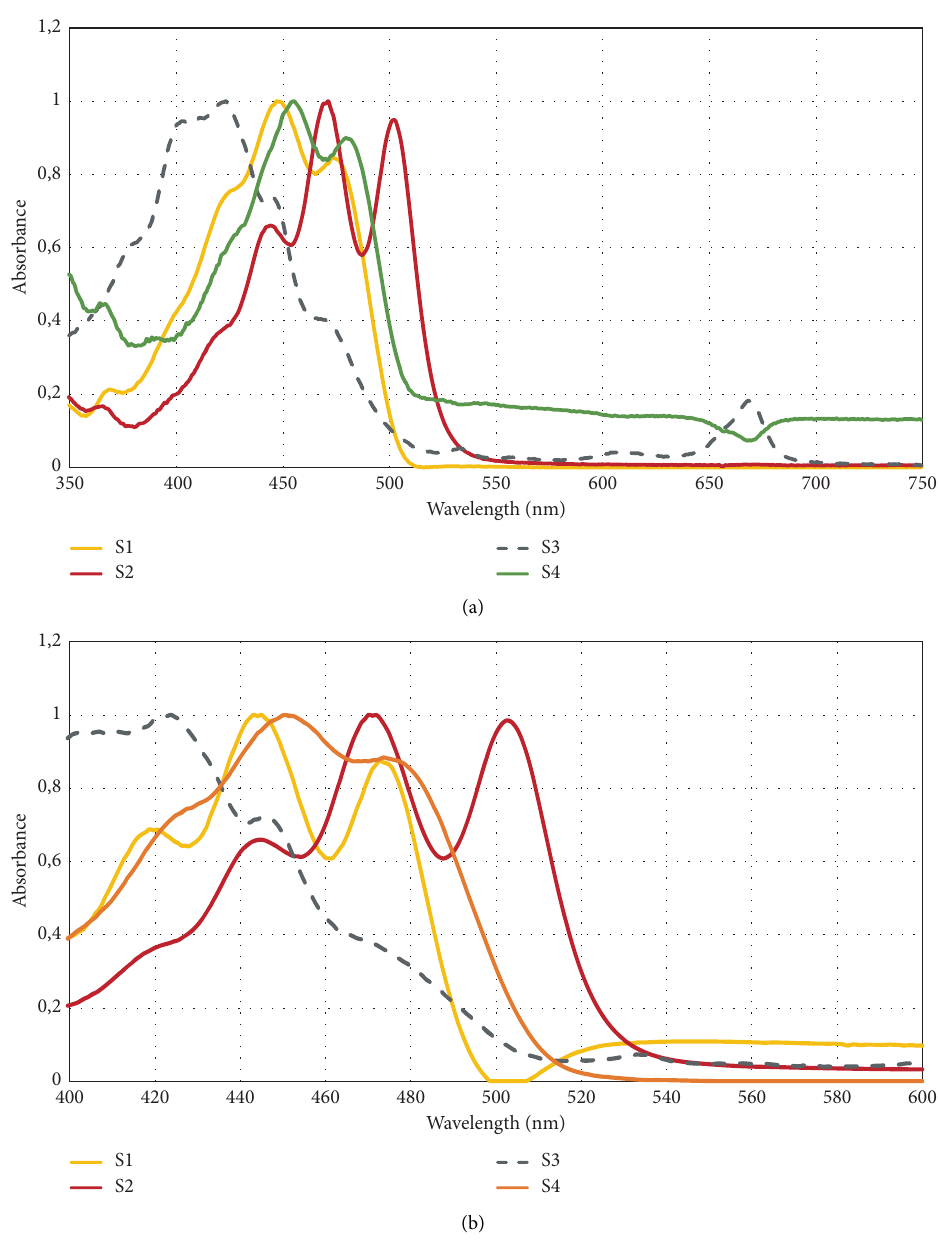
Figure 6: 4 pure spectra obtained after MCR-ALS procedure on standards and fruit extract spectra (a) from 350–750nm and (b) from